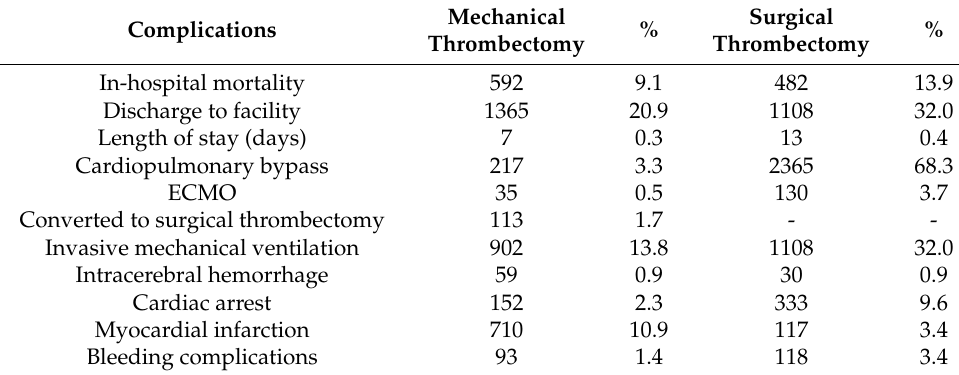
Table 2. Complications of mechanical thrombectomy and surgical